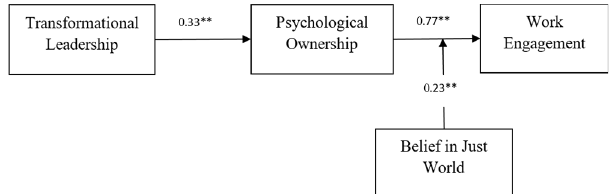
Figure 2. Moderated mediation